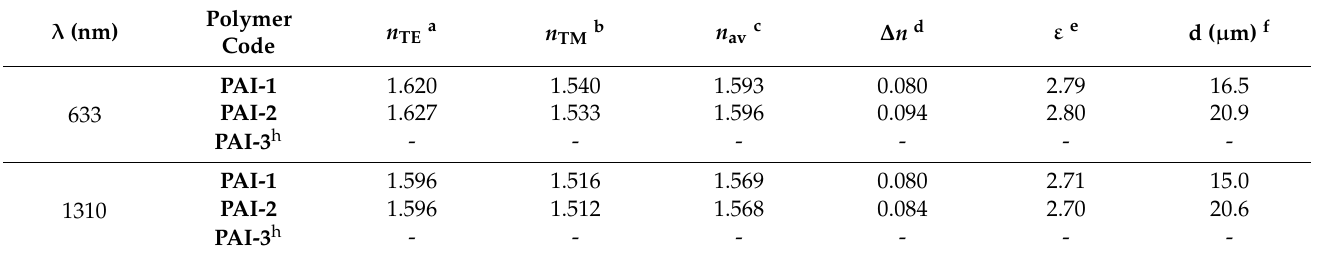
Table 4. Refractive indices of the PAIs.